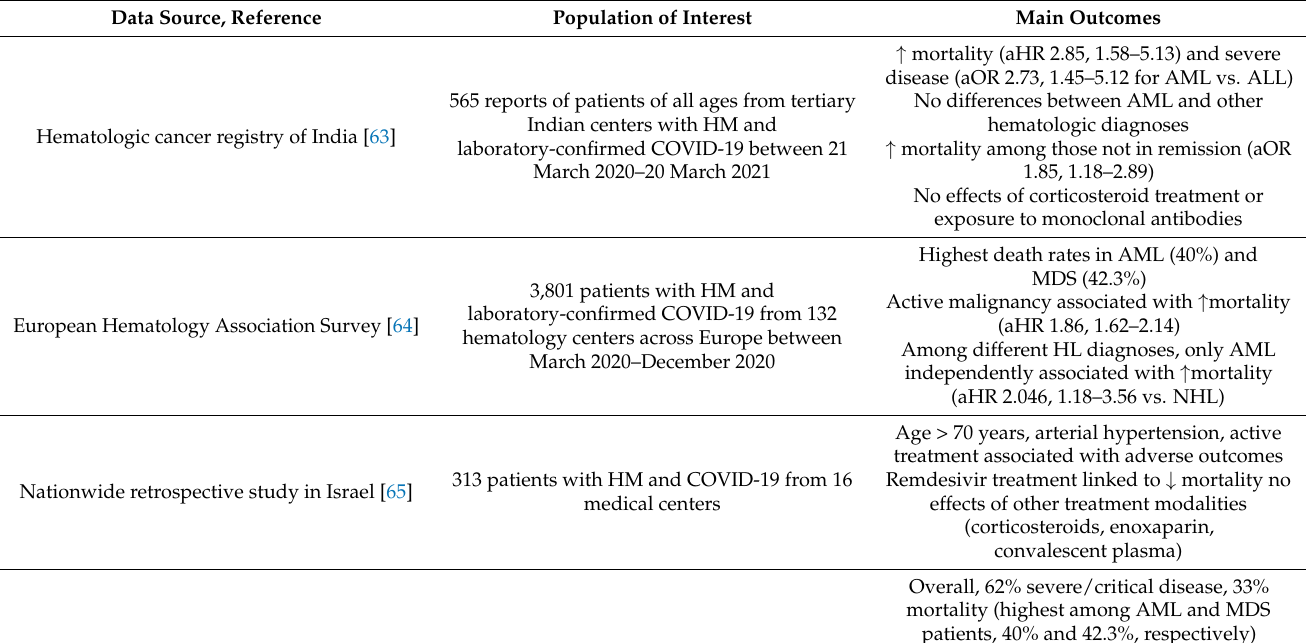
Overview of key studies addressing the impact of hematologic malignancies on COVID-19